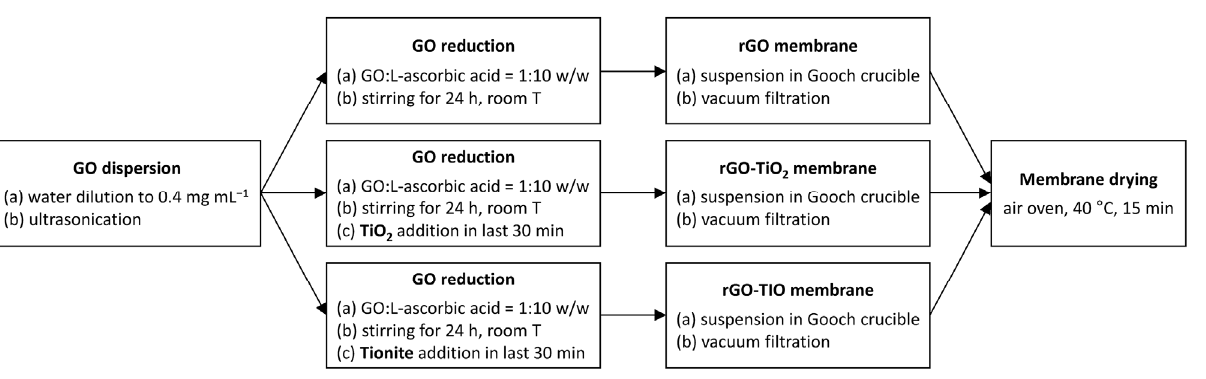
Figure 1. Flow diagram of the membranes production